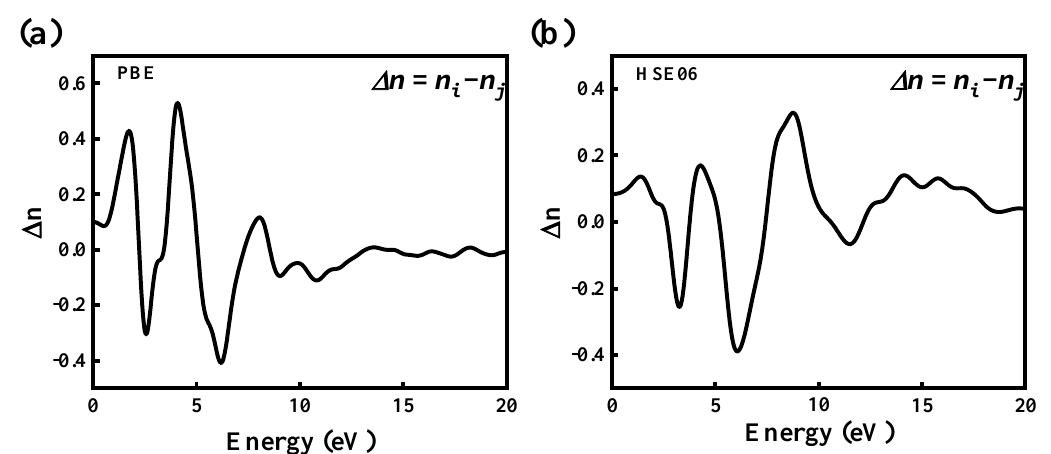
Figure 8. The birefringence of CdGeAs 2 . ( a ) GGA–PBE, ( b ) HSE06. According to Equation (7), the energy loss function of CdGeAs 2 is calculated, which describes the energy loss of the electrons when they pass through the medium. The energy loss spectrum of CdGeAs 2 is shown in Figure 9. The maximum energy loss peak at 16.36